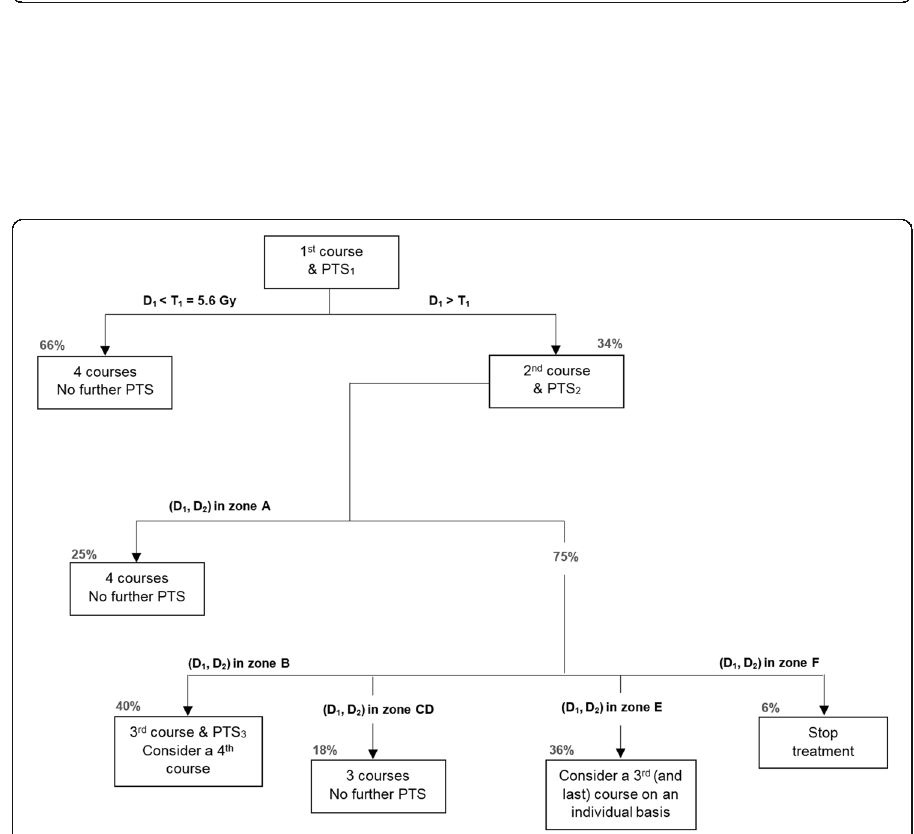
Fig. 7 Algorithm for the follow-up of renal dosimetry. Legend: Algorithm for the follow-up of renal dosimetry. Zones A – F are represented in Figs. 5 and 6. Percentages are indicated for our study